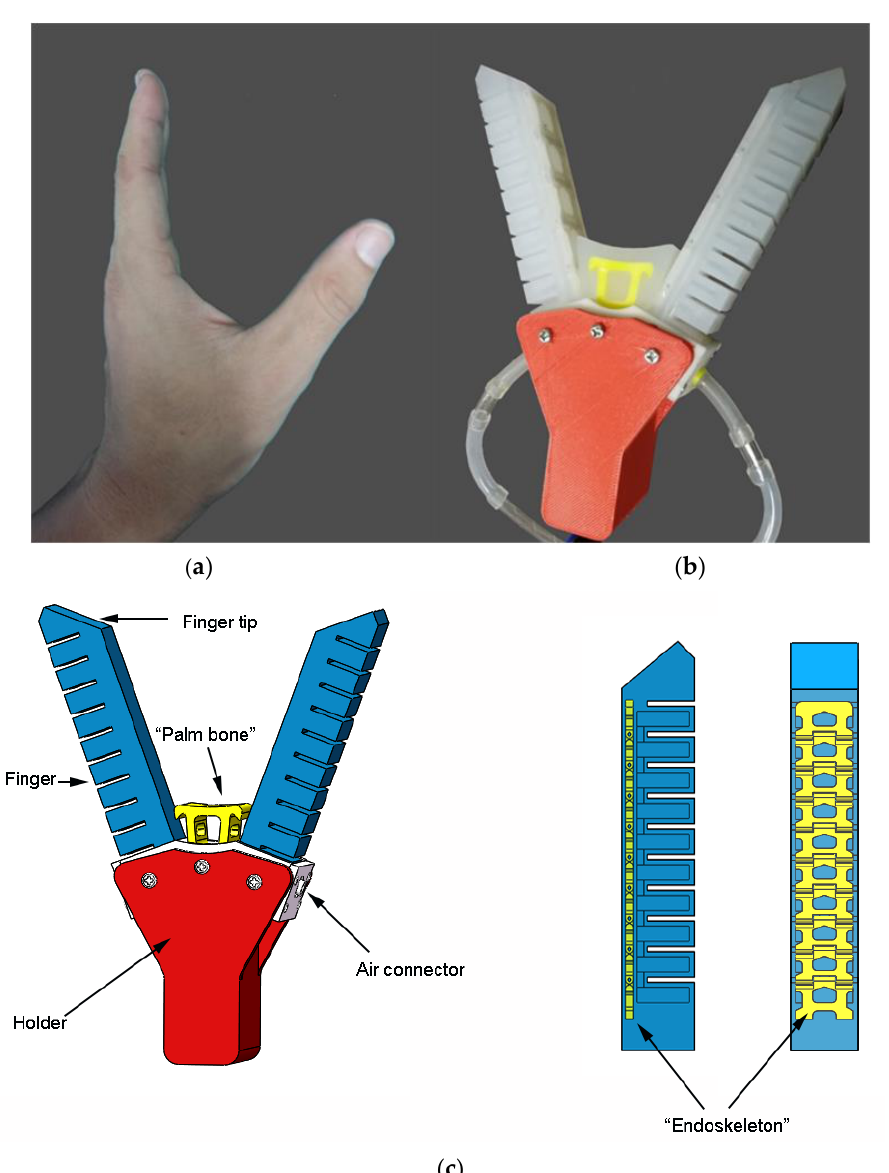
Figure 1. Design of endoskeleton pneumatic gripper: ( a ) hand; ( b ) gripper; ( c ) three-dimensional model.